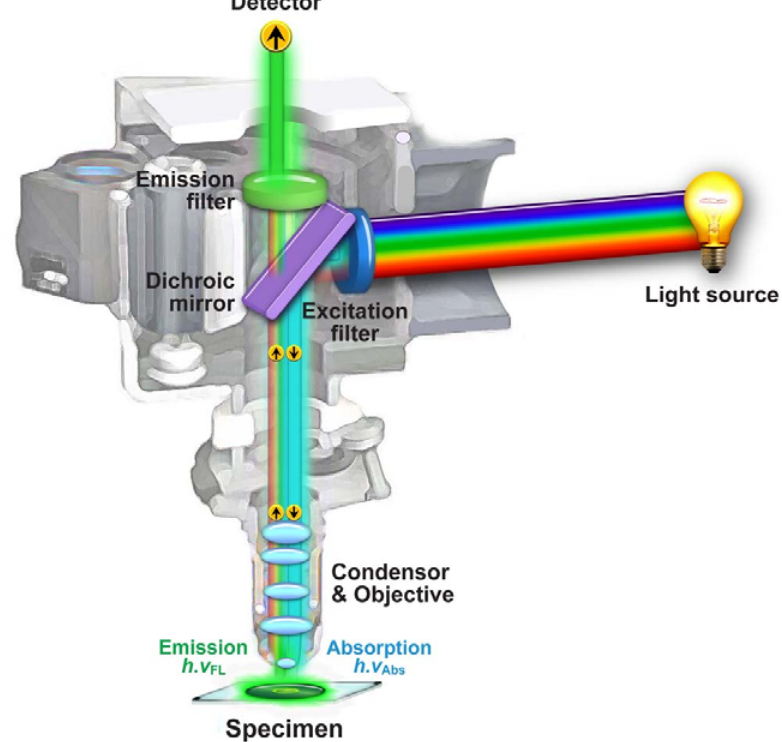
Figure 5. Anatomy of an epi -illumination fluorescence